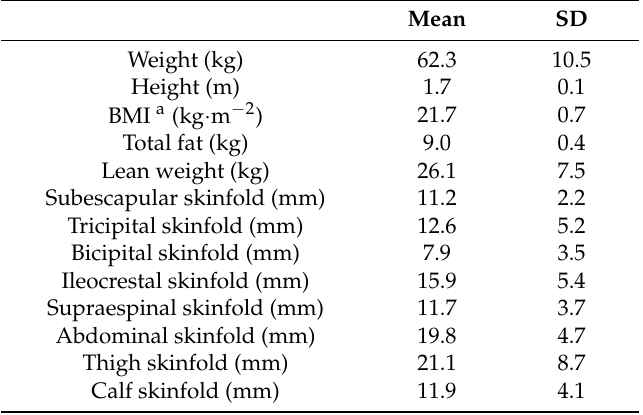
Table 4. Baseline physical characteristics of the triathletes ( n =